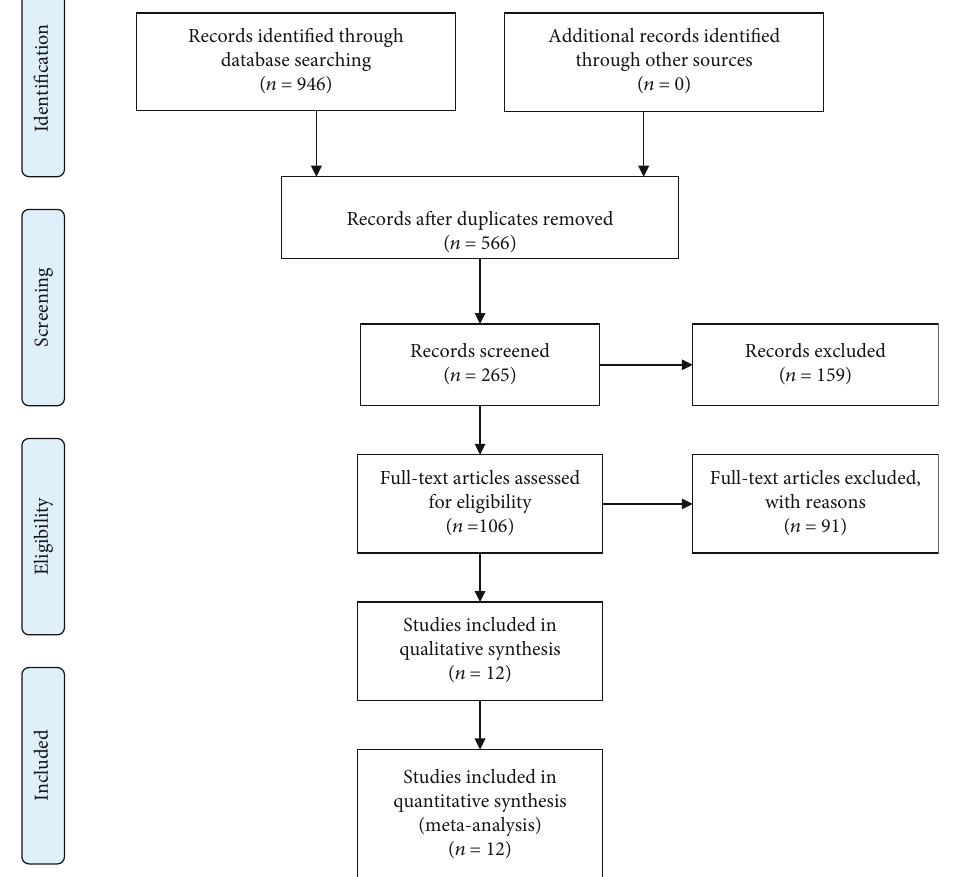
Figure 2: PRISMA 2009 fl ow